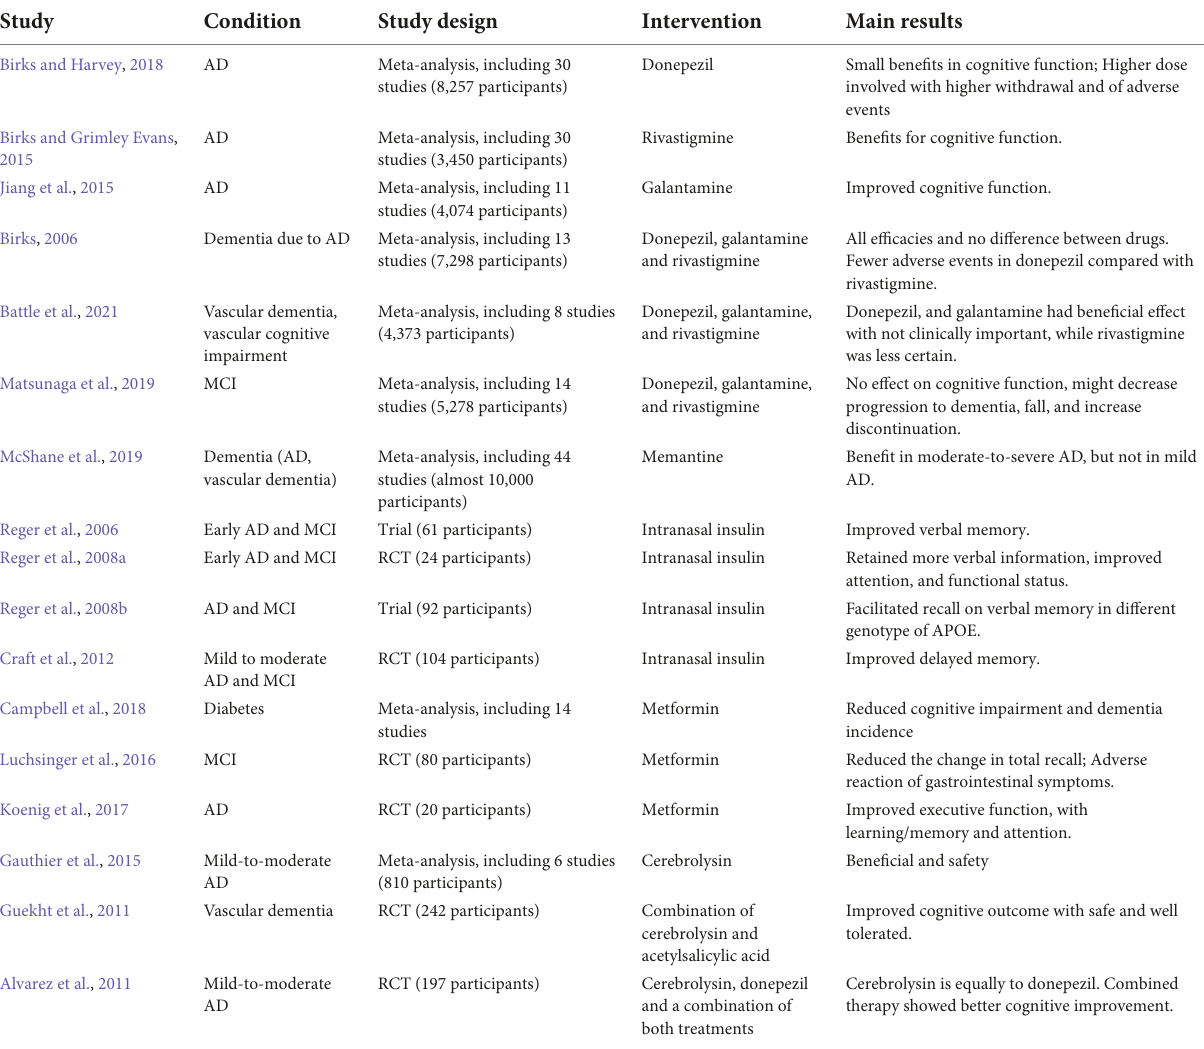
TABLE 1 Evidence of pharmacological interventions for cognitive impairment in older